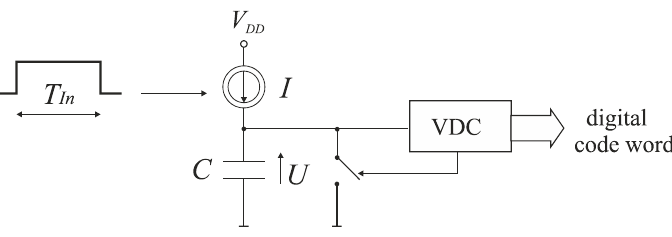
Figure 3. Diagram of TDC based on voltage-to-time translation.